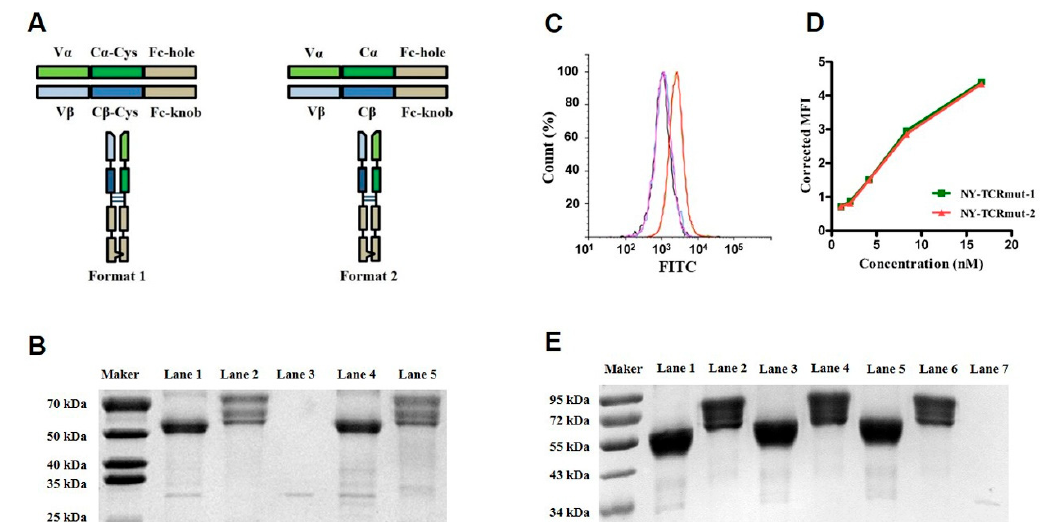
Figure 1. Soluble expressions of TCRs in mammalian cells. ( A ) Two Fc-fused formats of soluble TCR. Format 1: ECD α (with the C terminated cysteine)- GS -hinge region-CH2-CH3 (hole)- G 4 S -LPETGG and ECD β (with the C terminated cysteine)- GS -hinge region-CH2-CH3 (knob)- G 4 S -LPETGG form heterogeneous dimer. Format 2: ECD α (without the C terminated cysteine)- GS -hinge region-CH2-CH3 (hole)- G 4 S -LPETGG and ECD β (without the C terminated cysteine)- GS -hinge region-CH2-CH3 (knob)- G 4 S -LPETGG form heterogeneous dimer. ( B ) Analysis of the NY-TCRmut using SDS-PAGE in denatured condition after being de-glycosylated using PNGase F. Lane 1: deglycosylated NY-TCRmut of format 1. Lane 2: glycosylated NY-TCRmut of format 1. Lane 3: PNGase F (~30 kDa). Lane 4: deglycosylated NY-TCRmut of format 2. Lane 5: glycosylated NY-TCRmut of format 2. α and β chain of deglycosylated NY-TCRmut have a similar molecular size (~50 kDa). ( C ) Analysis of the antigen binding ability and specificity of NY-TCRmut on T2 cells. Black: T2 cells were directly incubated with fluorescent antibody (blank). Blue: T2 cells incubated with irrelevant peptide and NY-TCRmut of format 1 (control). Purple: T2 cells incubated with irrelevant peptide and NY-TCRmut of format 2 (control). Red: T2 cells incubated with relevant peptide and NY-TCRmut of format 1. Green: T2 cells incubated with relevant peptide and NY-TCRmut of format 2. ( D ) The binding ability of the two NY-TCRmut with A375-NY cells. ( E ) Analysis of the TCRs from format 1 using SDS-PAGE in denatured condition after being de-glycosylated by PNGase F. Lane 1: deglycosylated p53 R175H -TCR. Lane 2: glycosylated p53 R175H -TCR. Lane 3: deglycosylated Tax-TCR. Lane 4: glycosylated Tax-TCR. Lane 5: deglycosylated NY-TCRwt. Lane 6: glycosylated NY-TCRwt. Lane 7: PNGase F.